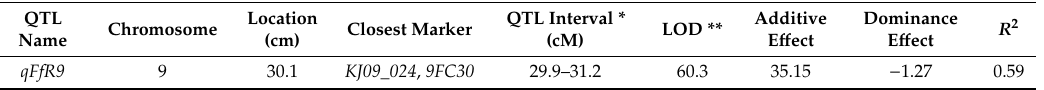
Table 3. Identification of quantitative trait locus (QTLs) for Bakanae disease (BD)